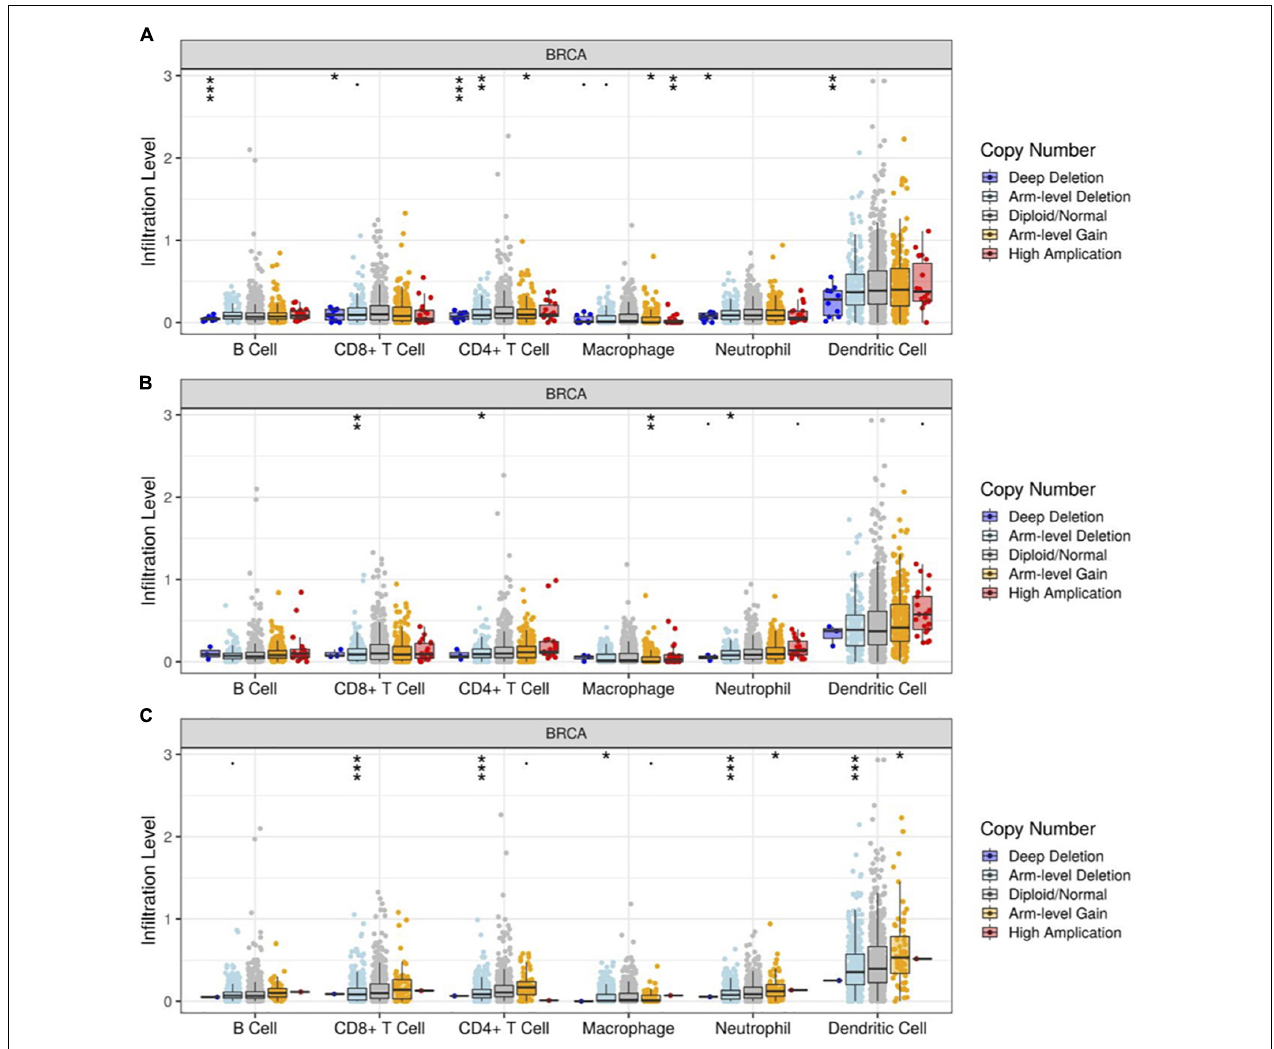
FIGURE 11 | Correlation between RUNX gene copy number and immune cell infiltration in breast cancer. The correlation between the gene copy number changes of (A) RUNX1, (B) RUNX2, and (C) RUNX3 with infiltration levels of B cells, CD8 + T cells, CD4 + T cells, macrophages, neutrophils, and dendritic cells in breast cancer were shown. * p < 0.05; ** p < 0.01; and *** p <